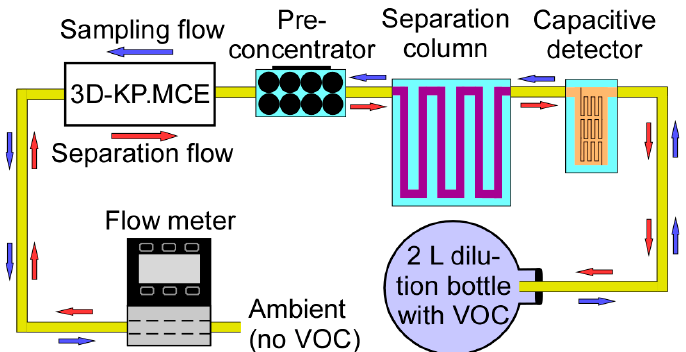
Figure 12. A micro gas chromatography system, including a preconcentrator, a separation column, a capacitive detector, and the 3D-KP.MCE. The test vapor was prepared in a 2 L dilution bottle. An external flow meter was connected to monitor the flow rate.